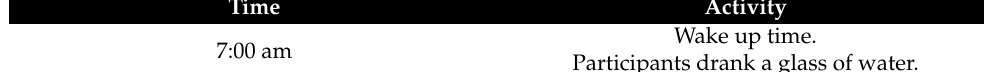
Table 1. Workcation